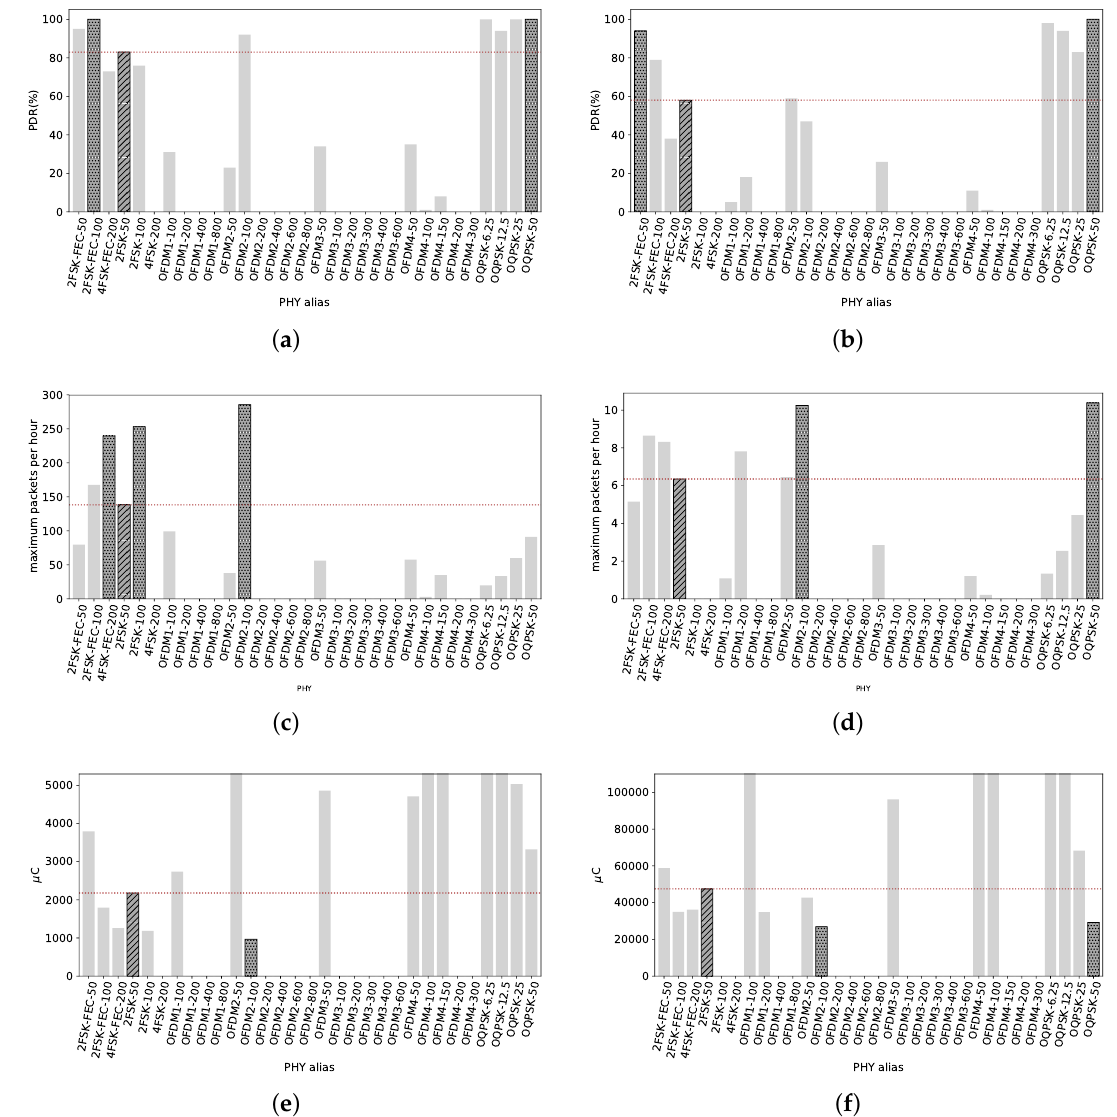
Figure 8. Line of Sight, 700 m. Only O-QPSK and FSK radio settings are able to provide the highest reliability. This node is close to the limits of the coverage. OFDM radio settings have a poor performance at this distance, but the difference is that OFDM transmissions are at least 3 dBm weaker that the rest of the PHYs. ( a ) PDR at 700 m from TX with packets of 127 B. Highest reliability achieved with 2FSK-FEC-100, OQPSK-6.25, OQPSK-12.5 and OQPSK-50. The reference has 83% PDR. OFDM2-100 has also higher reliability than the reference; ( b ) PDR at 700 m from the TX with packets of 2047 B. The reference has 58% PDR, while 2FSK-FEC-50 94% PDR and OQPSK-50 100% PDR; ( c ) Maximum amount of 127 B packets that can be correctly sent within an hour. 4FSK-FEC-200 and 2FSK-100 can send 239 and 253 short packets. OFDM2-100 can send up to 285 packets, while the reference only 138 packets; ( d ) Maximum amount of 2047 B packets that can be correctly sent within an hour. OFDM2-100 and OQPSK-50 can send up to 10 packets, while the reference 2FSK-50 just 6 packets; ( e ) Average electric charge consumption per packet of 127 B. OFDM2-100 consumes the less electric charge, 964 µ C while 2FSK-50 consumes 2178 µ C; ( f ) Average electric charge consumption per packet of 2047 B. OFDM2-100 and OQPSK-50 are the less electric charge-hungry radio setting, consuming 26.8 mC and 29.1 mC respectively while 2FSK-50 consumes almost the double, 47.5